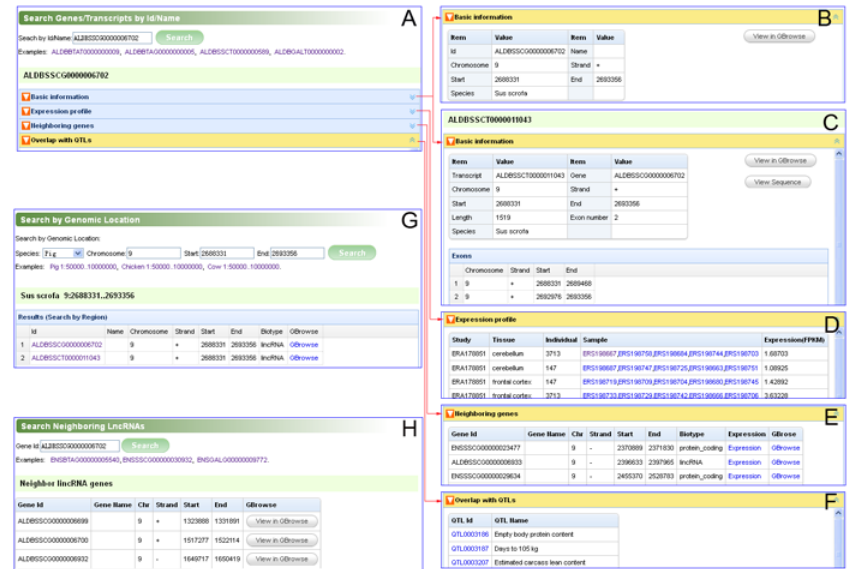
Fig 4. Screenshot of the search pages. ( A ) Search for transcripts or genes by their ids or names. ( B ) Basic information for a gene. ( C ) Basic information for a transcript. ( D ) The expression levels of genes in various tissue samples. ( E ) About ten genes adjacent to the current gene are represented. ( F ) The QTLs which overlap with the current gene or transcript. ( G ) Search for transcripts or genes by genomic region. ( H ) Search for neighboring lncRNAs of protein-coding